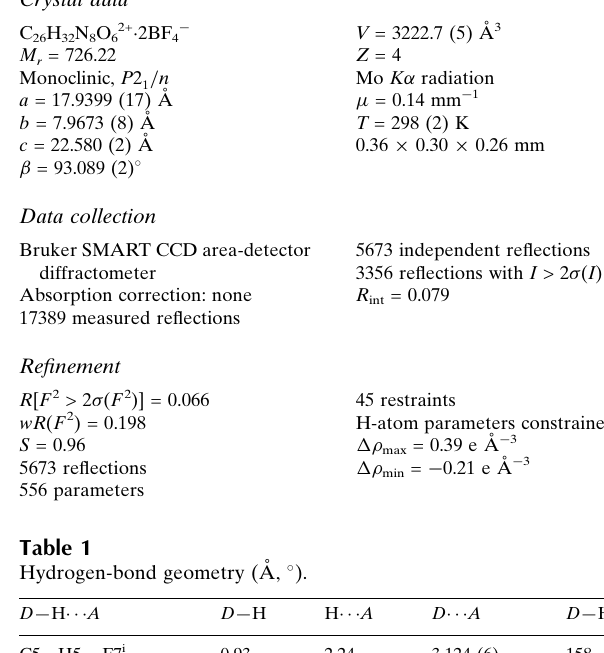
up from four fused rings, viz . two nearly planar imidazole rings and two triazine rings exhibiting chair conformations. One ethoxy group is disordered between two positions in an approximate ratio 3:2. The F atoms of the two anions are each rotationally disordered between two orientations in the same 3:2 ratio. The crystal structure is stabilized by intermolecular